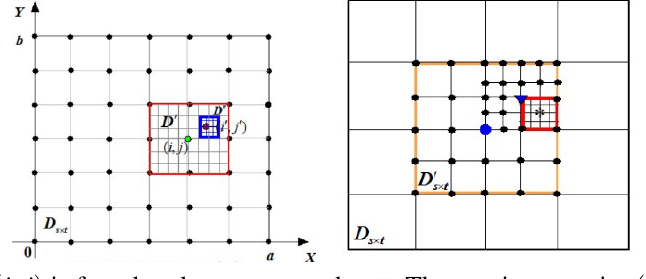
Fig. 4 Schematic diagram of K -level hierarchical random